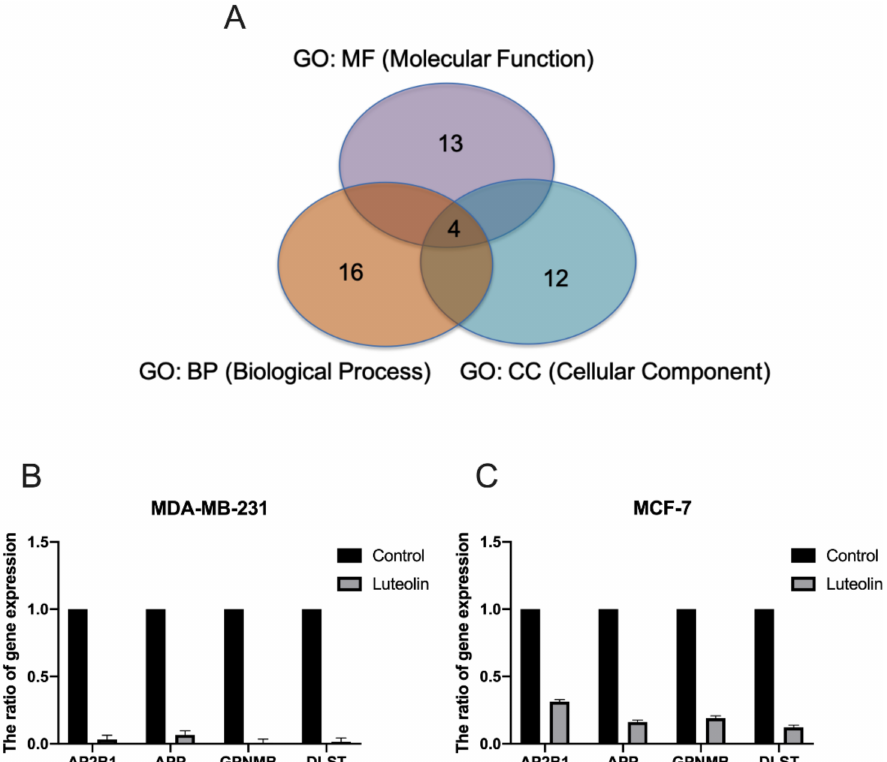
Figure 4. Effect of luteolin on the expression of selected genes in breast cancer cells. ( A ) Four identified genes, AP2B1, APP, GPNMB and DLST, were found to be involved in ‘molecular function’, ‘biological processes’ and ‘cellular components’. ( B , C )The expression of AP2B1, APP, GPNMB and DLST was examined in MCF-7 and MDA-MB-231 cells treated with 20 µ M luteolin using reverse transcription-quantitative PCR. The data are presented as the mean ± SD of three